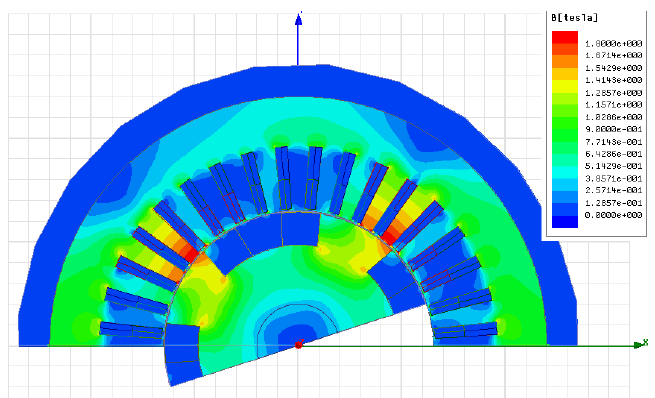
Figure 18. Flux distribution of Design